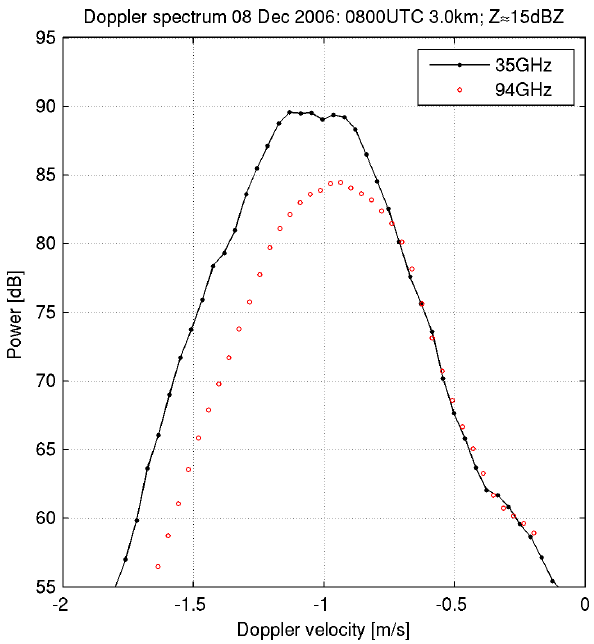
Figure 10. Example Doppler spectra recorded at 35 and 94GHz in Fig. 10. Example Doppler spectra recorded at 35 and 94 GHz in a deep ice cloud. The power (abscissa) is in a deep ice cloud. The power (abscissa) is in arbitrary units [dB]. arbitrary units [dB].